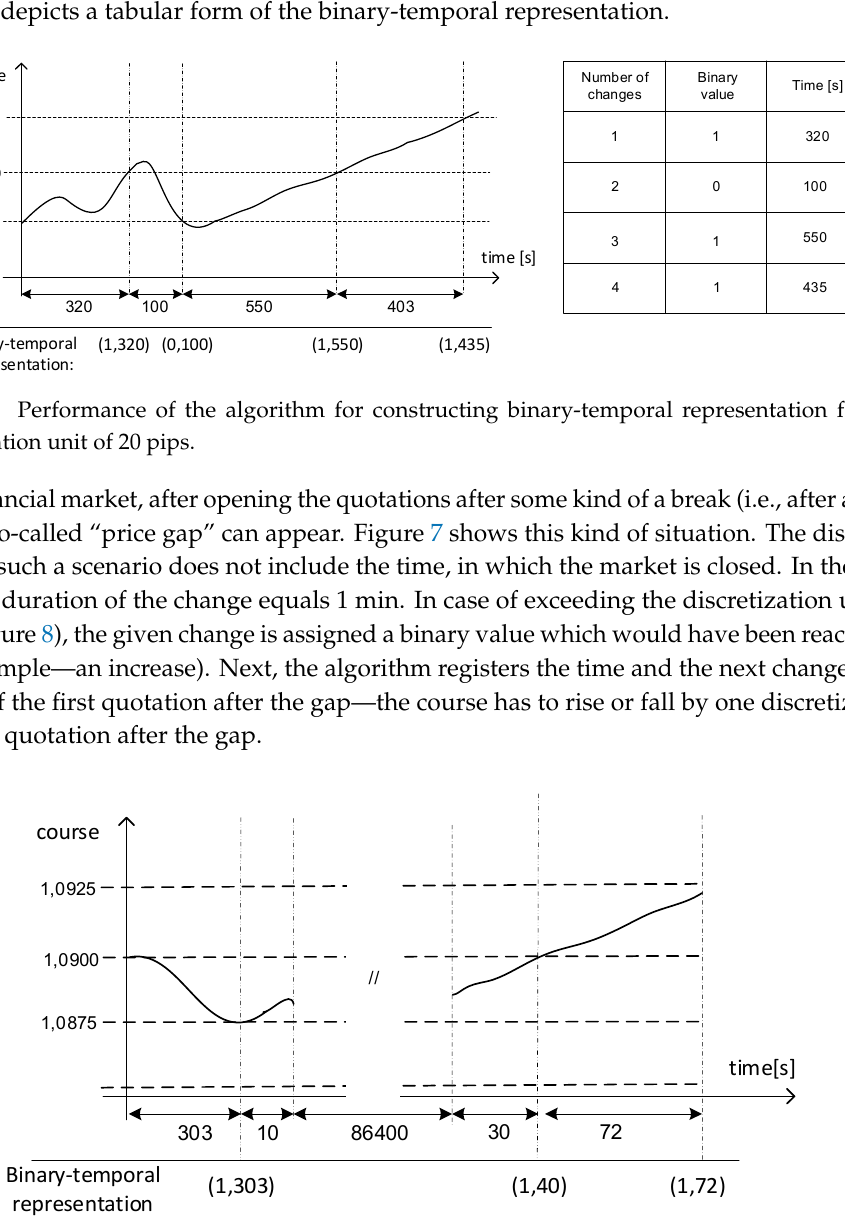
Figure 7. Binary-temporal representation algorithm’s performance during the session opening/closure.